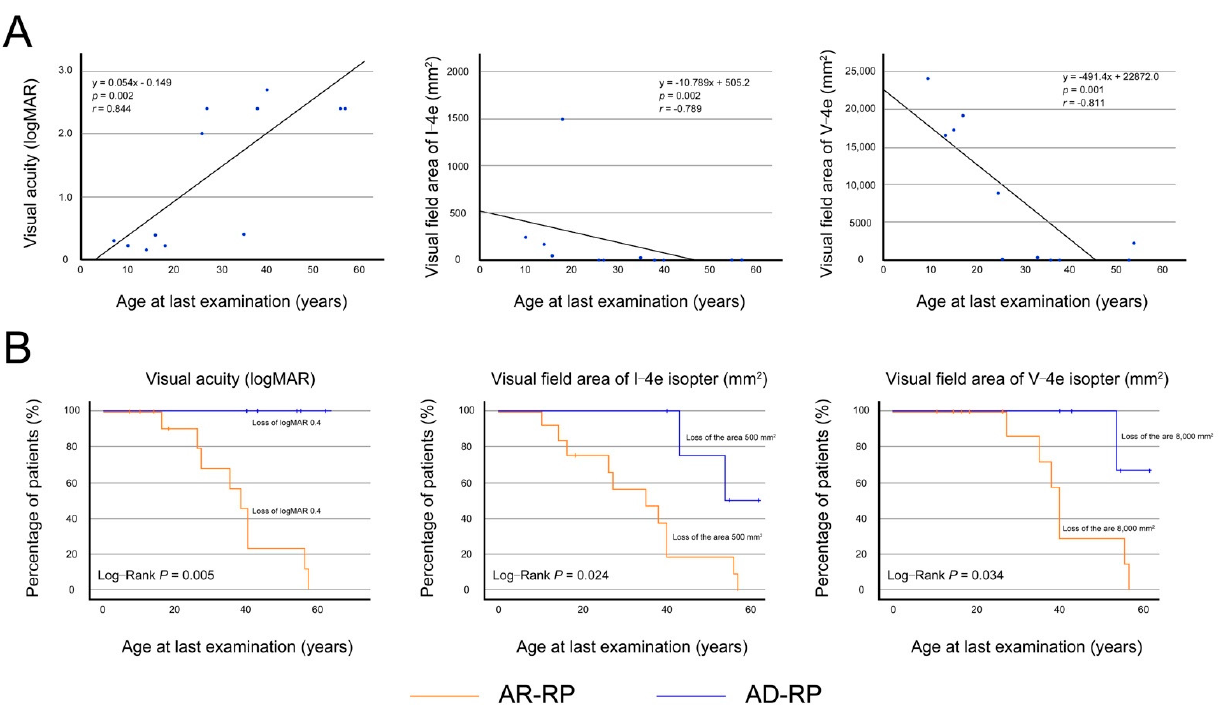
Figure 4. Visual acuity and visual field areas in patients with autosomal recessive retinitis pigmentosa. ( A ) In the left eyes ( n = 13) of the 13 patients with autosomal recessive retinitis pigmentosa, the graphs show scatter plots of the logarithm of the minimum angle of resolution (logMAR) best-corrected visual acuity (BCVA) and visual field areas of I-4e and V-4e isopters as a function of the age at last examination. There was significant correlation between the BCVA and age (r = 0.844, p = 0.002, Spearman’s rank-order correlation), and between the visual field areas of I-4e and V-4e and age (r = − 0.789, p = 0.002; r = − 0.811, p = 0.001, respectively). Each graph indicates age-dependent deterioration, reaching to severe impairment around the 50s. ( B ) The graph shows the Kaplan–Meier survival curves, with log-rank tests, for visual acuity and visual field areas of I-4e and V-4e isopters in patients with autosomal recessive (AR)-retinitis pigmentosa (RP) and autosomal dominant (AD)-RP. The following cutoff points were used: BCVA ≤ 0.4 logMAR units (0.4 decimal units), I-4e isopter area ≤ 500 mm 2 (10 ◦ ), and V-4e isopter area ≤ 8000 mm 2 (40 ◦ ). Patients with AR-RP show significantly faster progression in the loss of visual acuity ( p = 0.020) and visual field areas of I-4e ( p = 0.011) and V-4e isopters ( p = 0.024) in comparison to patients with AD-RP. The survival curves indicate that visual acuity and visual field areas are relatively preserved in most patients with AD-RP until their 40s but are severely impaired in most patients with